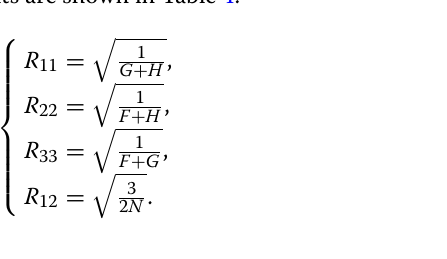
Figure 4 Location of four nodes along the radial direction